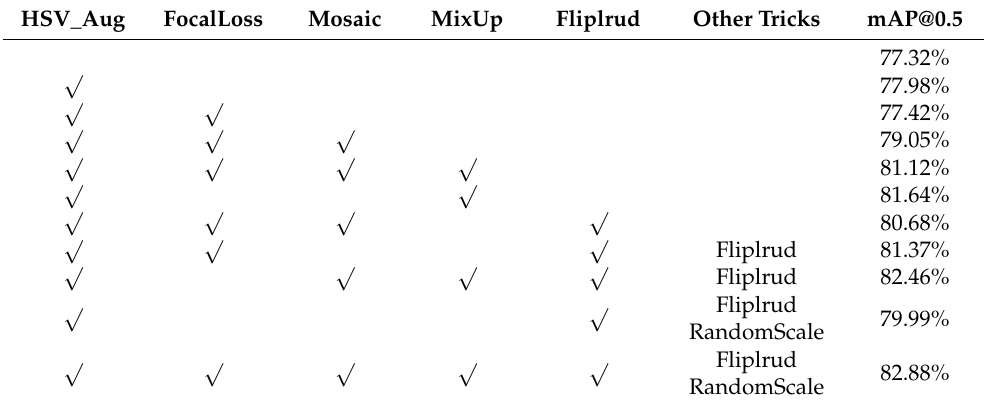
Table 5. Ablation experiments were performed on R-YOLOv5s, each time using a different training strategy. Using each strategy has an impact on the model, but it is worth noting that the addition of FocalLoss makes the model performance